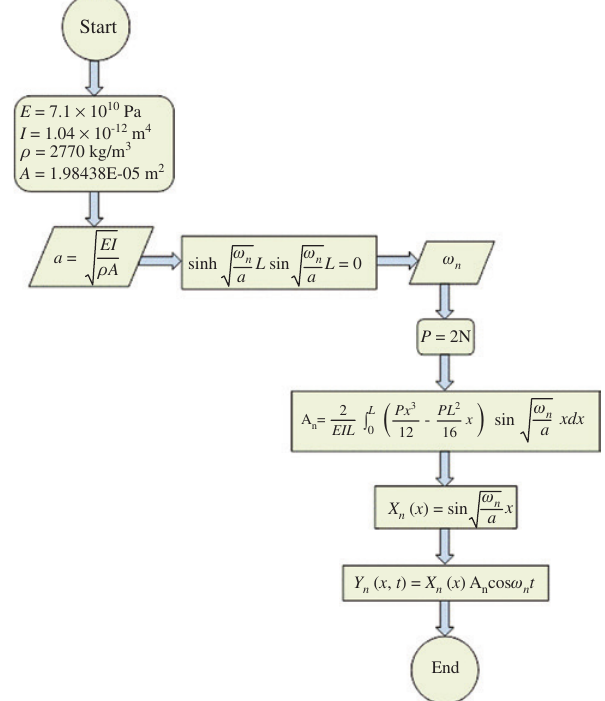
Figure 1: Flowchart of the MATLAB computer programming code used to solve the cantilever beam system.